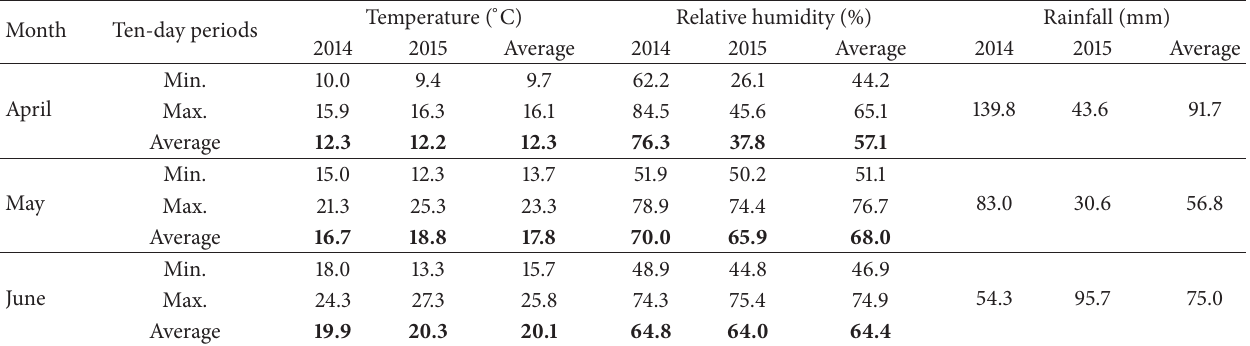
Table 1: Weather data in the Pleven